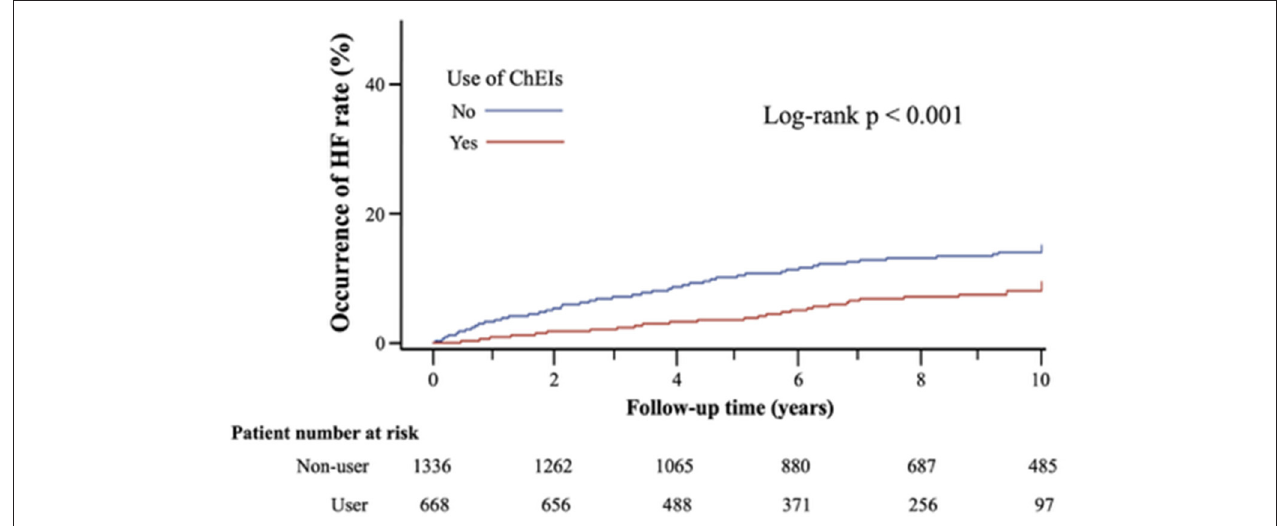
FIGURE 2 | Kaplan-Meier survival curves of new onset of HF after 10-years follow-up in matched cohort.